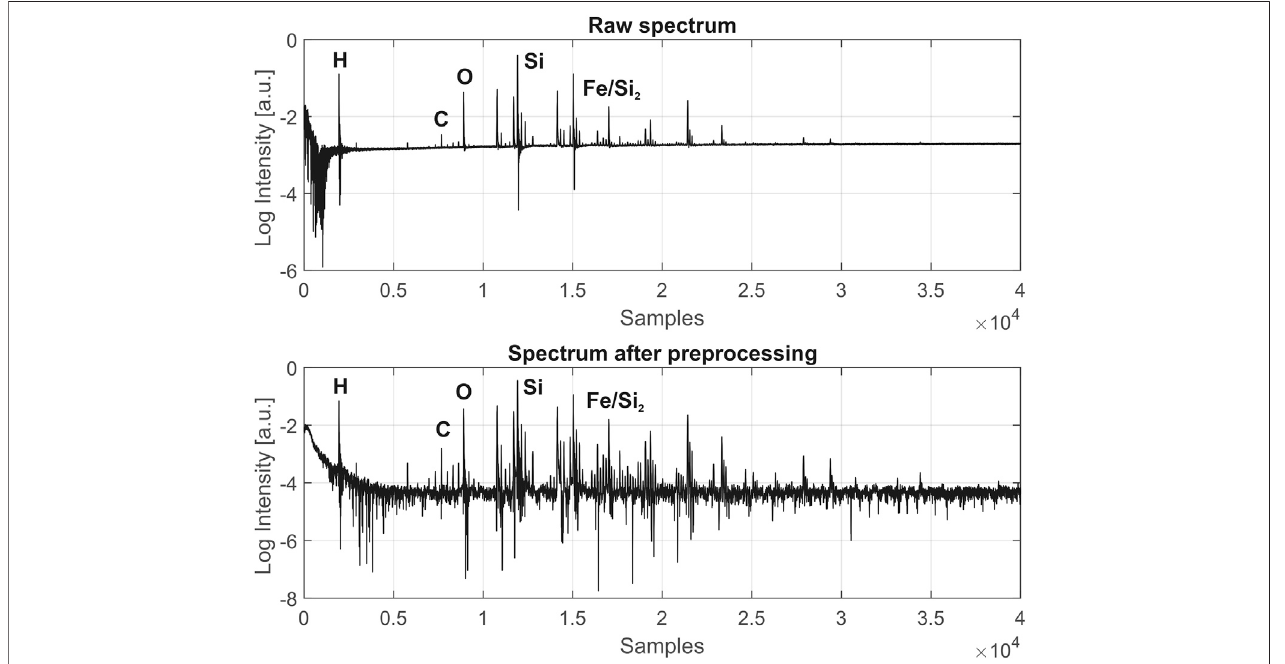
FIGURE3| Comparisonoffs-LIMSspectra(compositespectrumof200lasershots,recordedfromsingleposition),beforeandafterdatapreprocessing,acquired from the Gun fl intchertsample. Each linein thespectrum representsa single unit mass. The increase ofSNR to10 4 and correction ofthebaselinecan benoted. See the text for the full description of preprocessing procedures. Exemplary atomic lines are denoted on top of the spectrum.